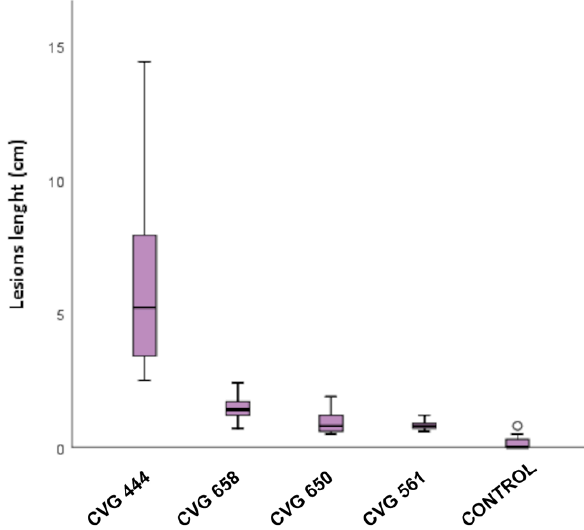
Figure 8. Box plot showing the results of the pathogenicity tests. Boxes represent the interquartile range, while the horizontal line within each box indicates the average value. The Kruskal-Wallis test was carried out to compare the mean lesion lengths (cm) from inoculation with four representative isolates, and significant differ- ence was accepted for P <0.05. Table 4. Evolutionary models as determined by MrModeltest (Nylander